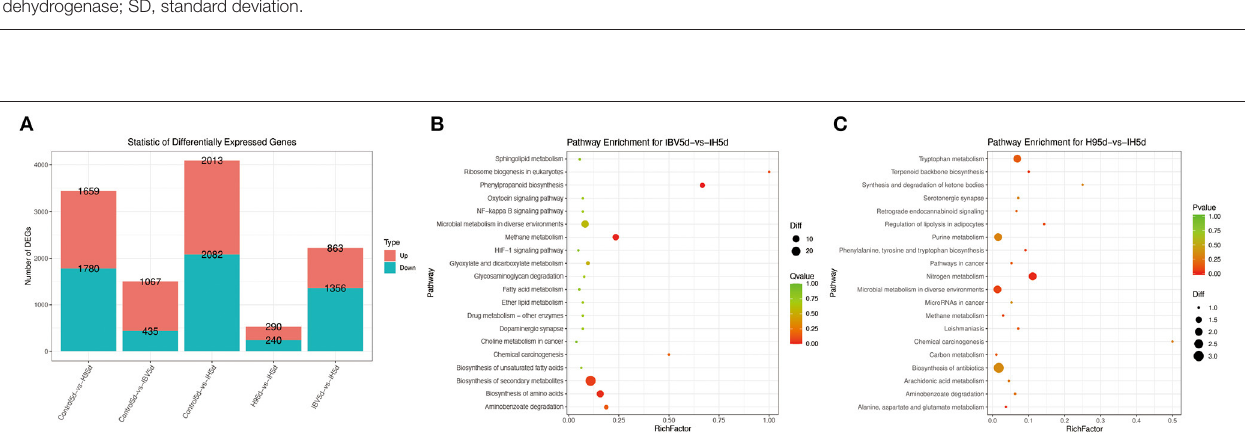
FIGURE 12 | Effect of co-infection with IBV and H9N2 virus on the NLRP3 inflammasome. Samples from the trachea, lungs, and kidneys were collected at 5 dpi. The protein expression of NLRP3 in the trachea, lungs, and kidneys was determined using a western blot. The expression of mature IL-1 β was determined using ELISA. Protein expression levels of NLRP3 in the trachea (A) , lungs (B) , and kidneys (C) . Intensity band ratios of NLRP3 to GAPDH in the trachea (D) , lungs (E) , and kidneys (F) . Expression levels of mature IL-1 β in the trachea (G) , lungs (H) , and kidneys (I) . Data are presented as means ± SD. “a” indicates a significant difference ( P < 0.05) between the three co-infection groups and the IBV group. “b” indicates a significant difference ( P < 0.05) between the three co-infection groups and the H9N2 group. IBV, infectious bronchitis virus; NLRP3, NLR family pyrin domain containing 3; ELISA, enzyme-linked immunosorbent assay; GAPDH, glyceraldehyde 3-phosphate dehydrogenase; SD, standard deviation.